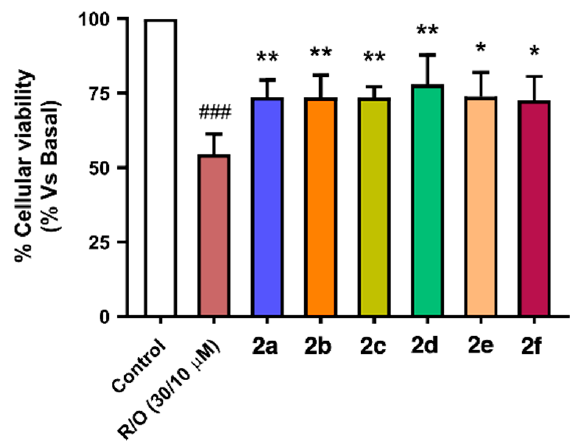
Figure 7. Neuroprotective capacity of compounds 2a – f against oxidative stress induced by the toxic combination of rotenone (30 µ M) and oligomycin A (10 µ M). SH-SY5Y neuroblastoma cells were treated with the corresponding compound 2 (1 µ M) for 24 h, then cells were co-incubated with the same compound and the R/O combination for further 24 h. Finally, cellular viability was assayed by the MTT method. Data are means of six different cultures in duplicate. One way ANOVA Newman Keuls post-hoc test: ### p < 0.001 compared to basal; * p < 0.05, ** p < 0.01 compared to R/O.